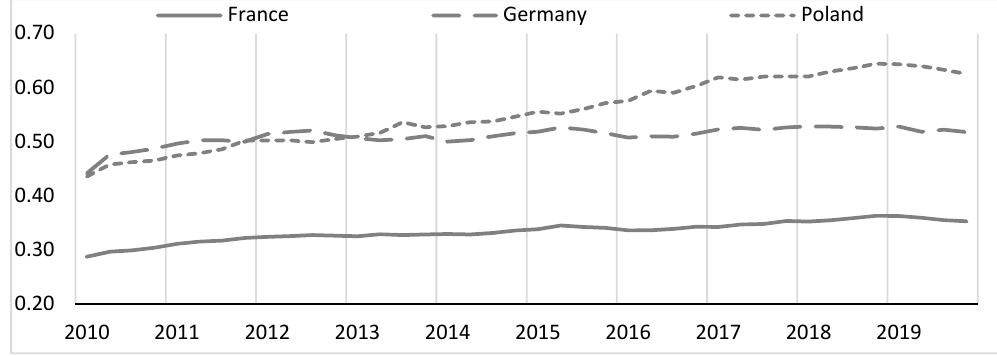
Figure 3. Export share in gross value added (factor e), own work, source: Eurostat.